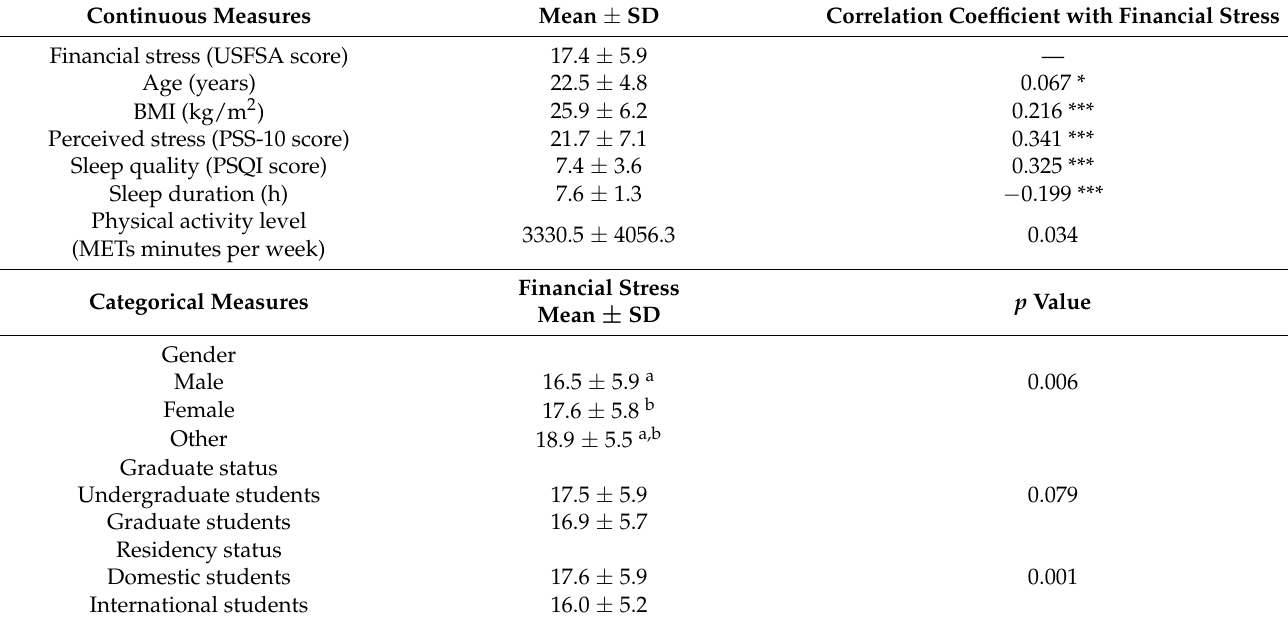
Table 2. Financial stress and its associations with demographic and health